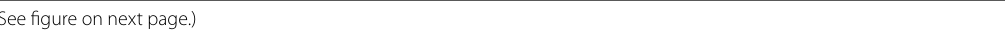
figure on next Fig. 1 Morphological changes of HEL cells influenced by DMAG. a Morphological changes of HEL cells induced by DMAG (10, 20 and 40 μM) for 6 days. Scale bar: 100 μm. b Giemsa staining showed the multinucleation of HEL cells treated with DMAG (10, 20 and 40 μM) for 6 days. The dark blue represents cell nucleus. Scale bar: 500 μm. c The expression of F‑actin of HEL cells is shown with phalloidin staining after the cells were treated with DMAG (10, 20 and 40 μM) for 6 days. Scale bar: 100 μm. Blue represents cell nucleus. Red indicates F‑actin. d Immunofluorescence analysis of the expression of VWF after DMAG (10, 20 and 40 μM) intervention for 6 days in HEL cells. VWF was visualized by green fluorescence and cell nucleus was stained with DAPI (blue). Scale bar: 100